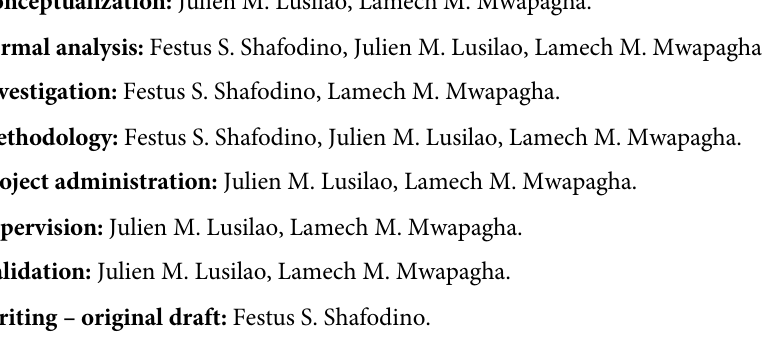
S1 Table. TLC profile of methanol extract of N . sativa seeds. Retention factor (Rf) values of the